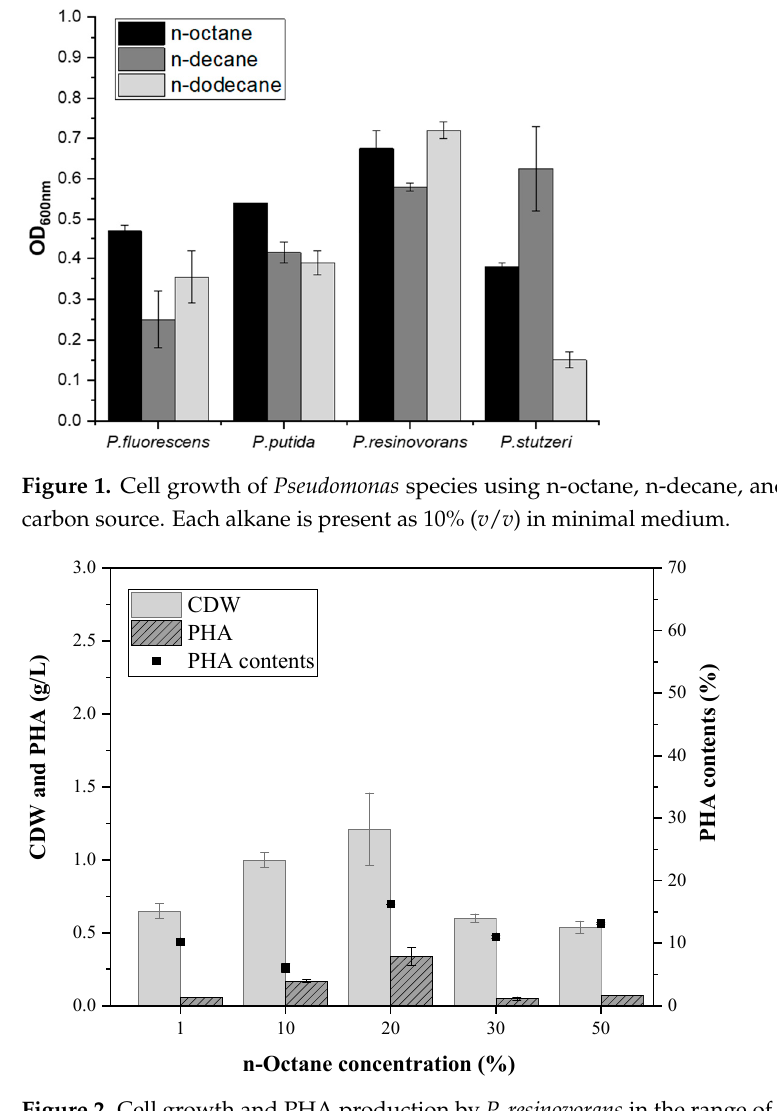
Figure 2. Cell growth and PHA production by P. resinovorans in the range of n-octane.